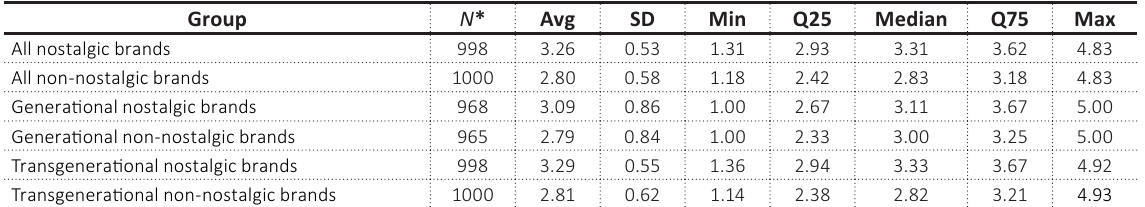
Source: Own study.